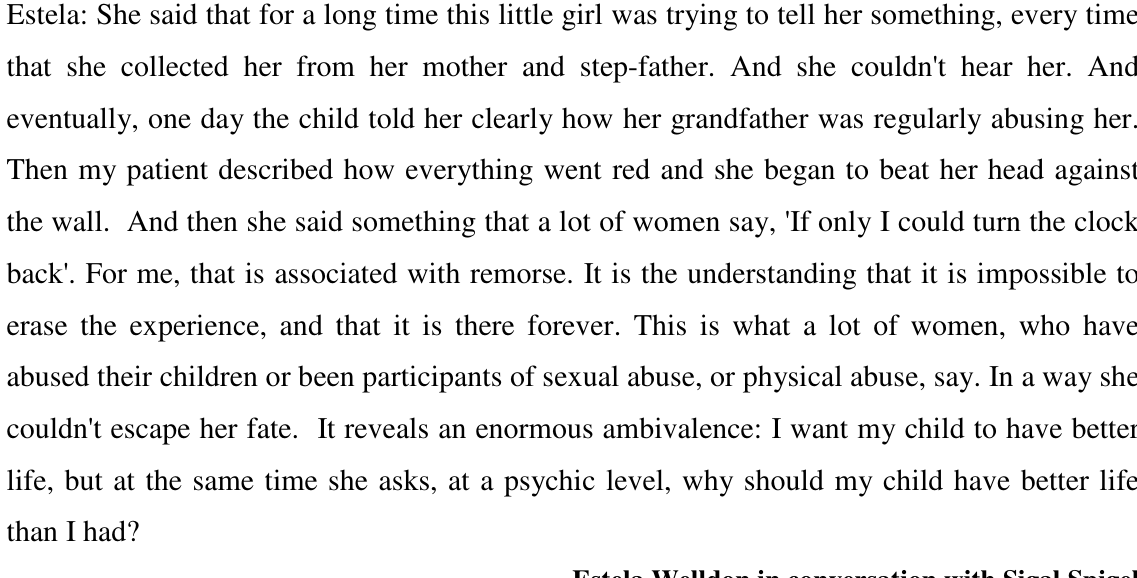
Estela Welldon in conversation with Sigal Spigel Introduction Sigal Spigel and Lisa